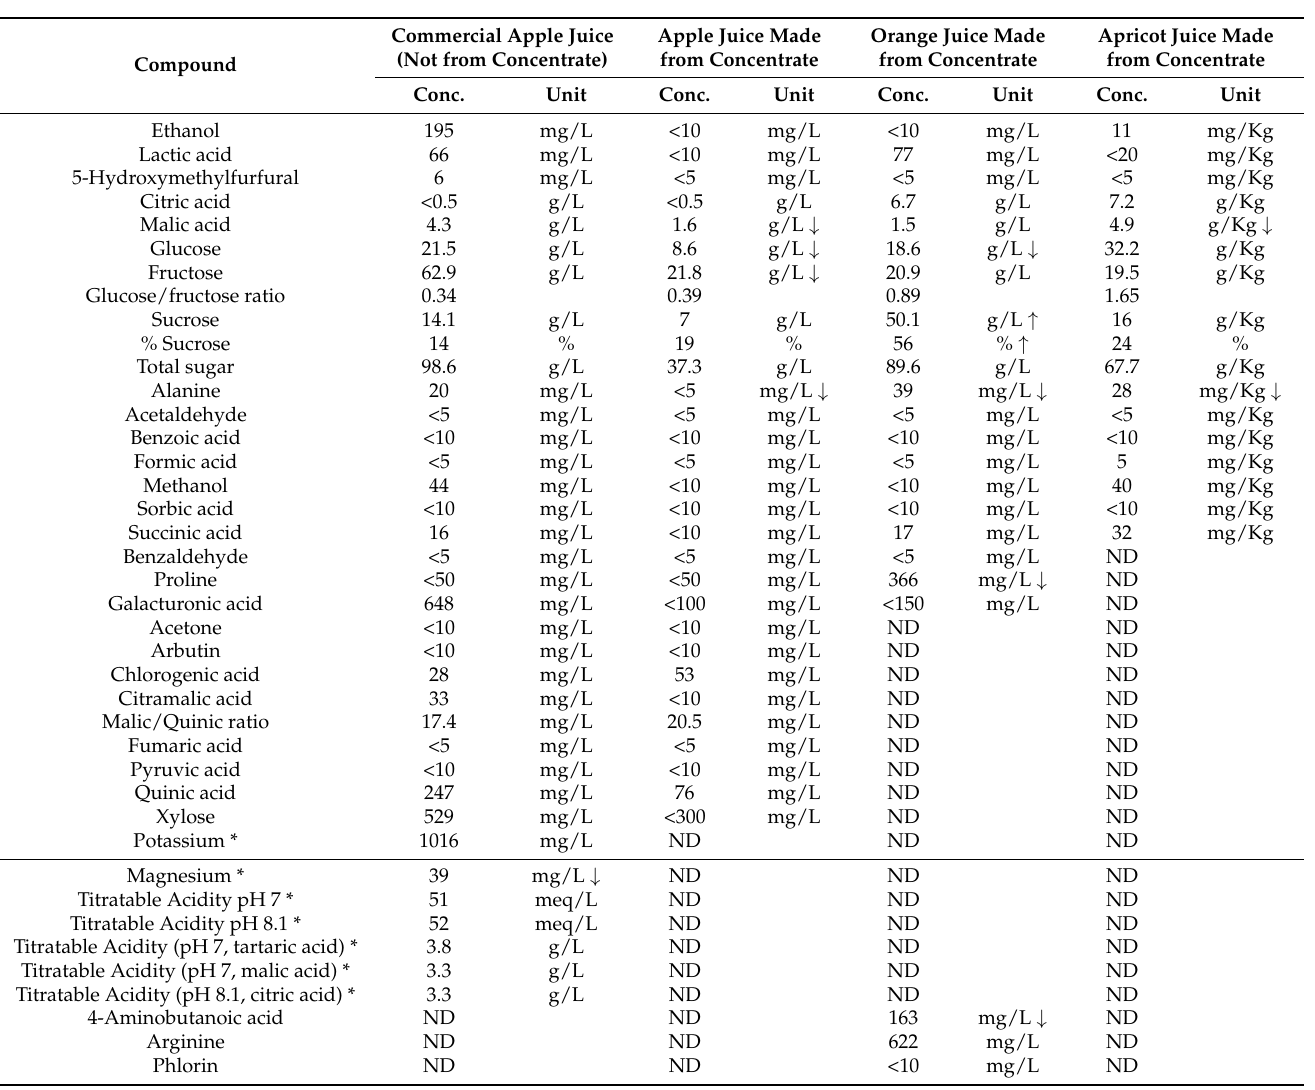
Table 1. Apple, orange, and apricot juice targeted analyses, comprising the quantification of 39 metabolites and physic- ochemical parameters (titratable acidity) used as compliance parameters defined at the AIJN Code of Practices of the European Fruit Juice Association